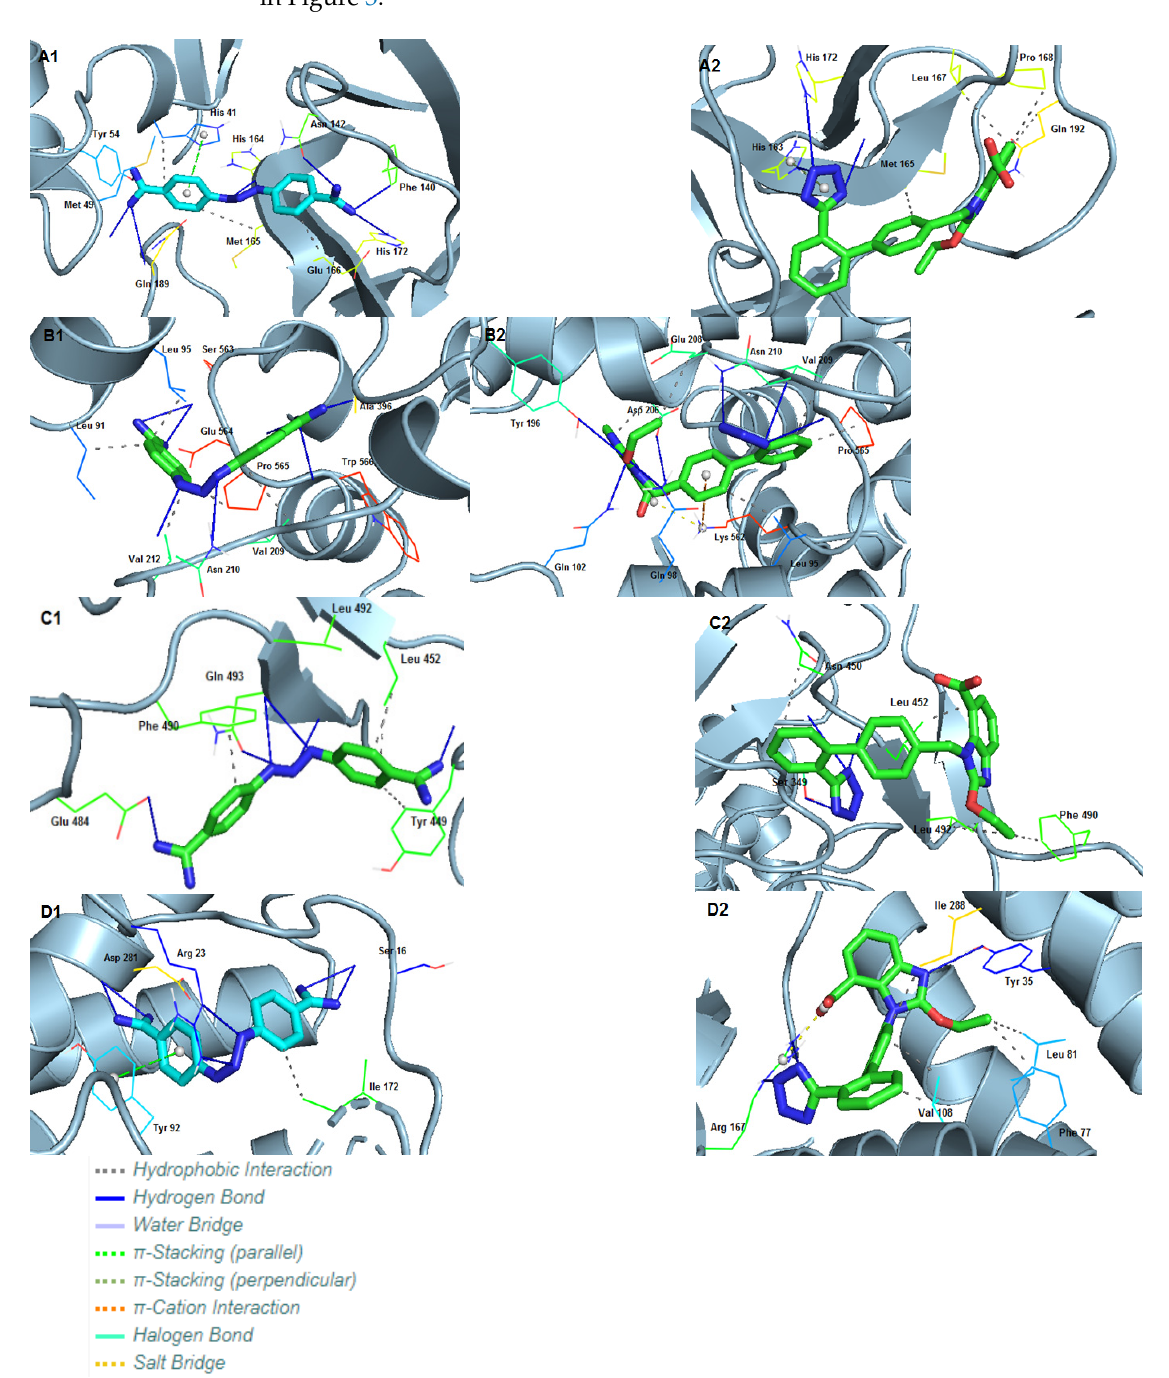
Figure 3. Crystallographic grids of DIZE and candesartan incorporation into the cavity of the SARS-CoV-2 spike protein. ( A1 ) DIZE and ( A2 ) candesartan incorporated into a cavity of Mpro of SARS-CoV-2 (PDB ID: 6LU7) using a crystallographic grid. ( B1 ) DIZE and ( B2 ) candesartan incorporated into a cavity of spike protein RBD (PDB ID: 6LZG) of SARS-CoV-2 using a crystallographic grid. ( C1 ) DIZE and ( C2 ) candesartan incorporated into a cavity of spike protein RBD (PDB ID: 7DDN) of SARS-CoV-2 using a crystallographic grid. ( D1 ) DIZE and ( D2 ) candesartan incorporated into a cavity of AT 1 R (PDB ID: 4YAY) using a crystallographic